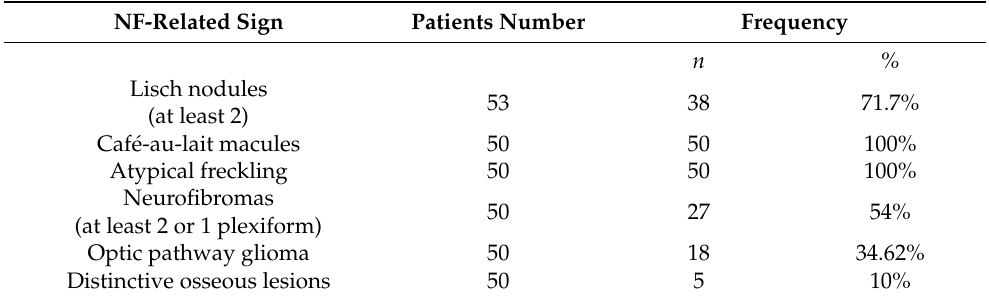
Table 4. Frequencies of other NF1-related signs presented by children at the age of 8 years old. NF-Related